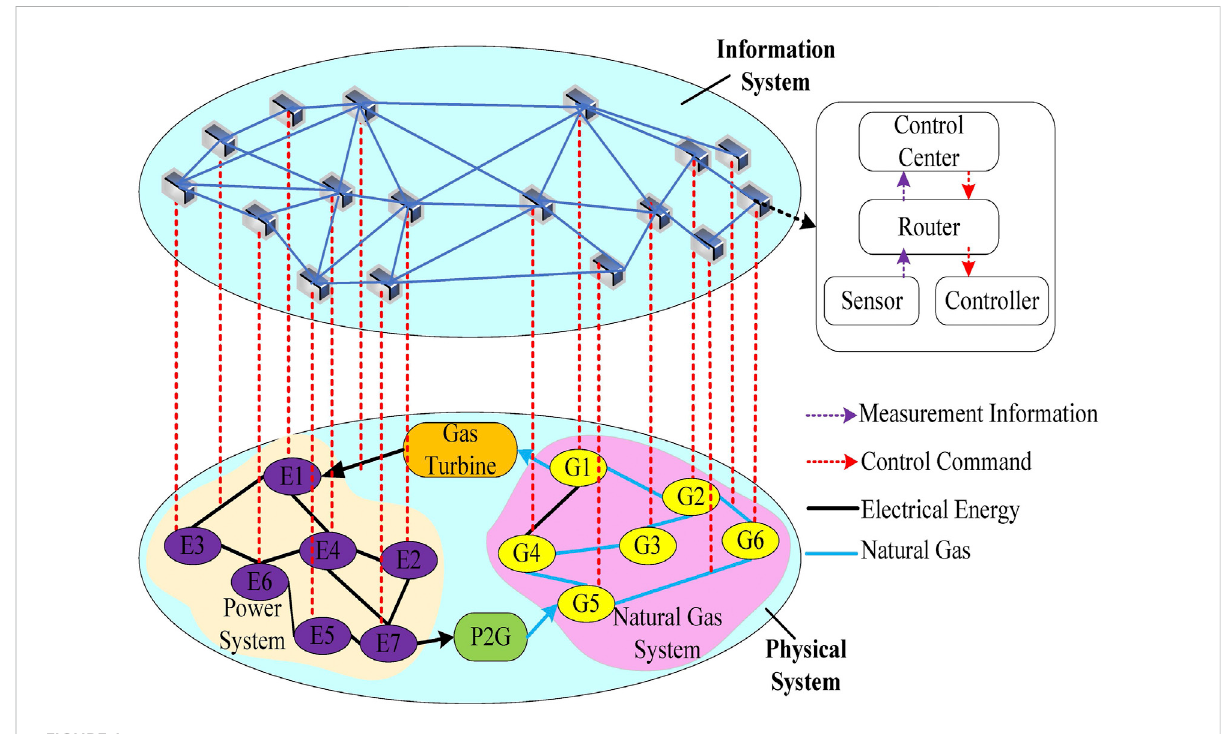
FIGURE 1 The structure of the CPS of